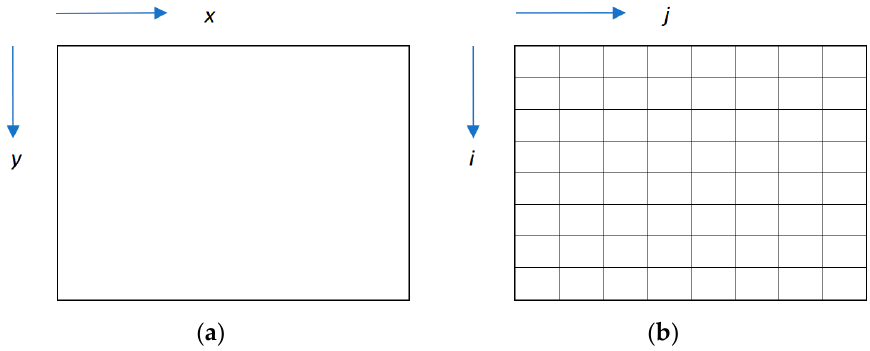
Figure 1. Representation of an image in a computer environment. ( a ) Continuous 𝑓(𝑥, 𝑦) . ( b ) Digital 𝑓(𝑖,𝑗) .